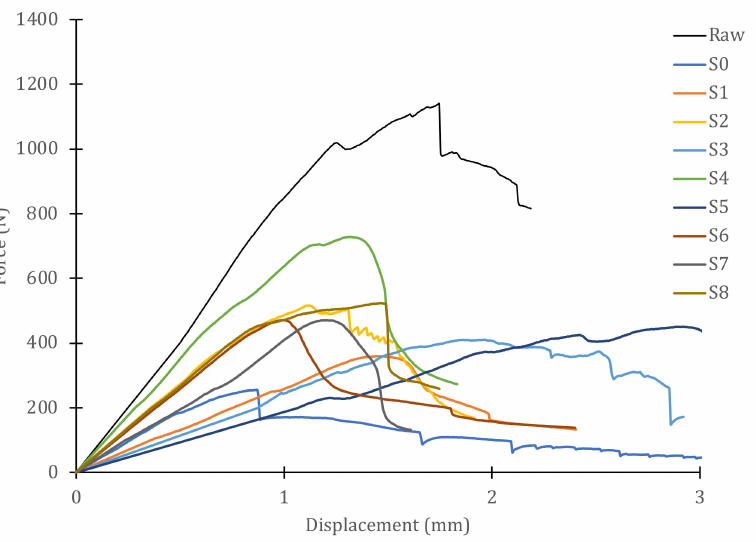
Figure 7. Iosipescu shear test curves for samples (dry/wet) from a GFRP panel with 900,000 cyclic